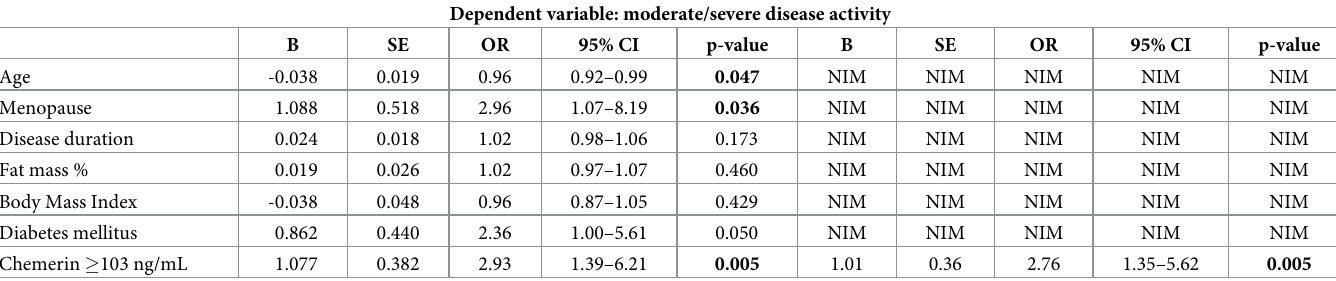
Table 3. Factors associated with moderate/severe disease activity in patients with rheumatoid arthritis in the multivariate analysis. Dependent variable: moderate/severe disease